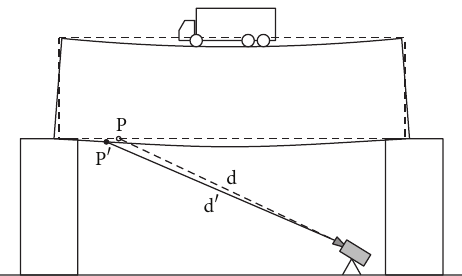
Figure 10: Sketch of the measurement geometry of the points P3 and P4 during the deformation of the deck.